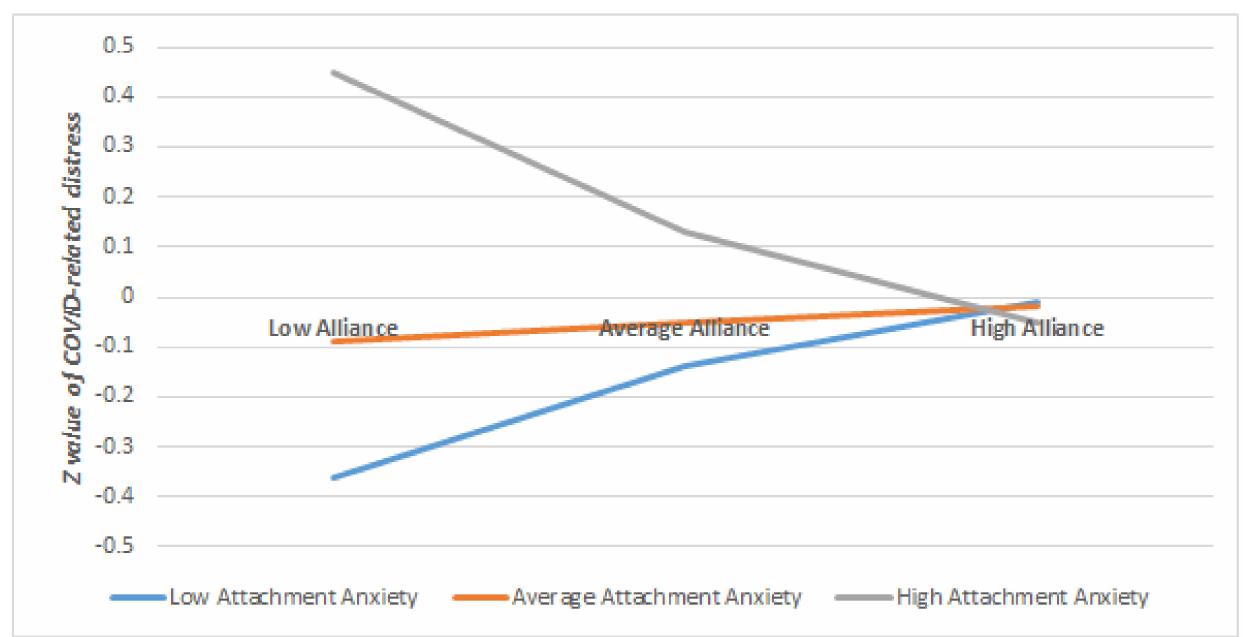
Figure 2. The Moderating Role of Attachment Anxiety on the Relationship between Working Alliance and COVID-related Traumatic Distress at Follow-up, once Controlled for Baseline Distress and Time